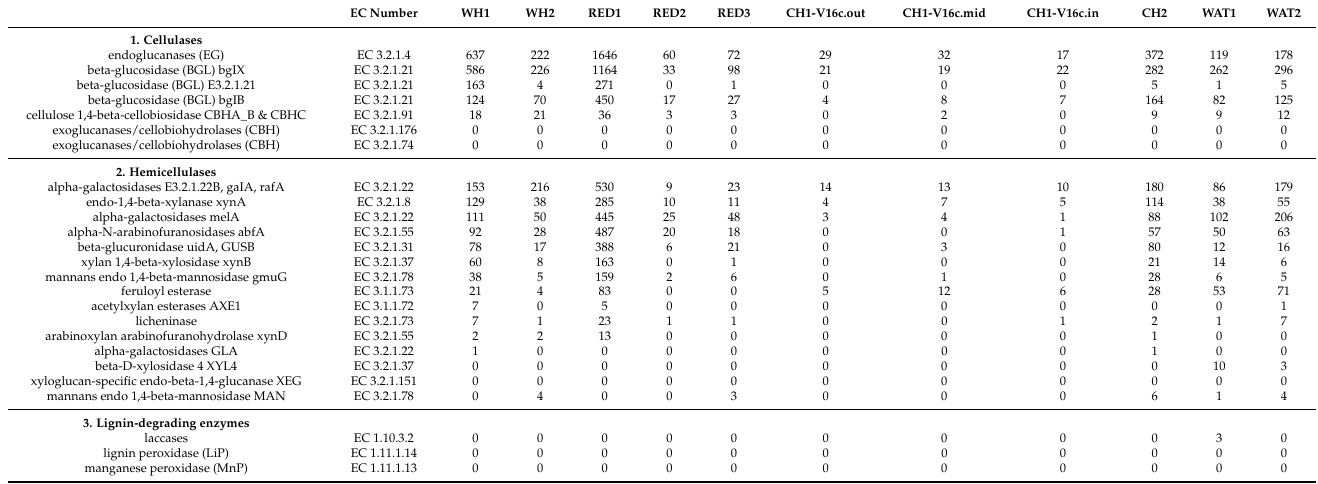
Table 1. Counts of genes (KEGG Orthologs) encoding the three major categories of biomass degrading enzymes in the 11 metagenomic libraries. Gene counts measure the relative abundance of each gene per sample